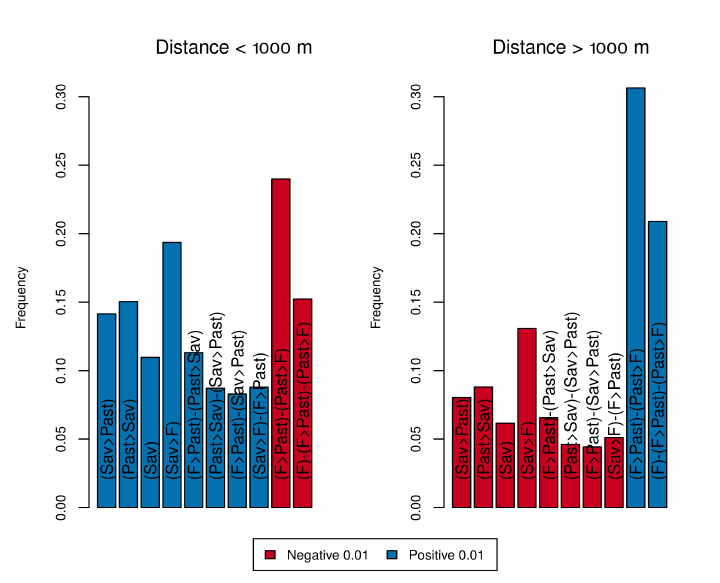
Figure 11. Ten most discriminating subsequences between areas proximate to a road (distance < 1000 m) and distant (distance > 1000 m).